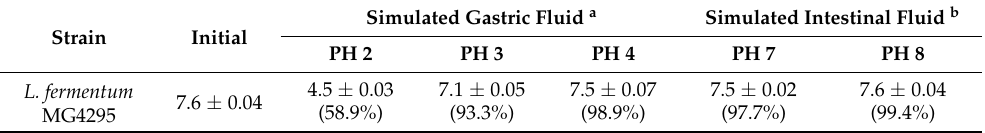
Table 1. Survivability of the probiotic candidate L. fermentum MG4295 under simulated GIT.